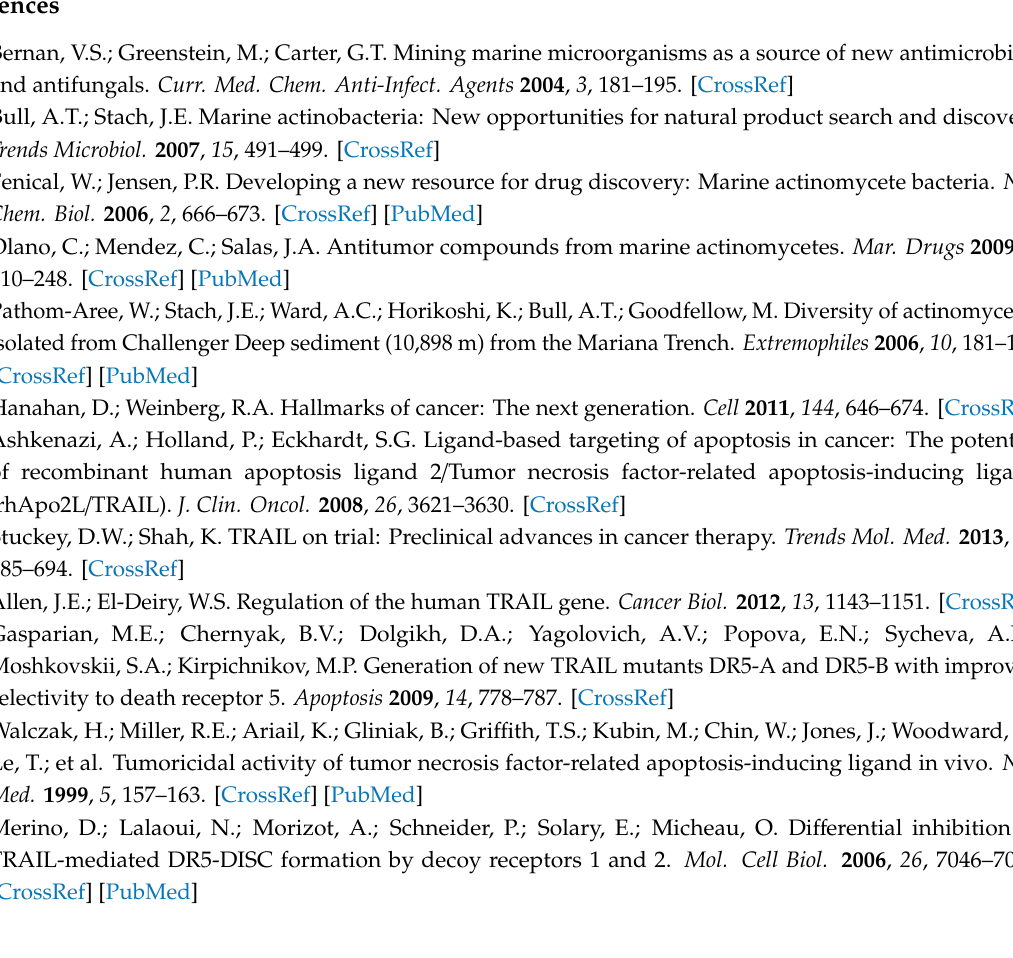
Figure S1: Flow cytometric analysis monitoring the e ff ect of pan-caspase inhibitor (QvD) on marine compound-induced apoptosis in HCT116 colon cancer cell line.; http: // www.mdpi.com / 2073-4409 / 9 / 8 / 1760 / s2, Figure S2: Autofluorescence screening and monitoring apoptosis-induced by marine compounds in HCT116 and Jurkat cells using flow cytometry; http: // www.mdpi.com / 2073-4409 / 9 / 8 / 1760 / s3, Figure S3: Detection of apoptosis induced by marine compounds in HCT116 and Jurkat isogenic cells; http: // www.mdpi.com / 2073-4409 / 9 / 8 / 1760 / s4, Figure S4: Raw western blot